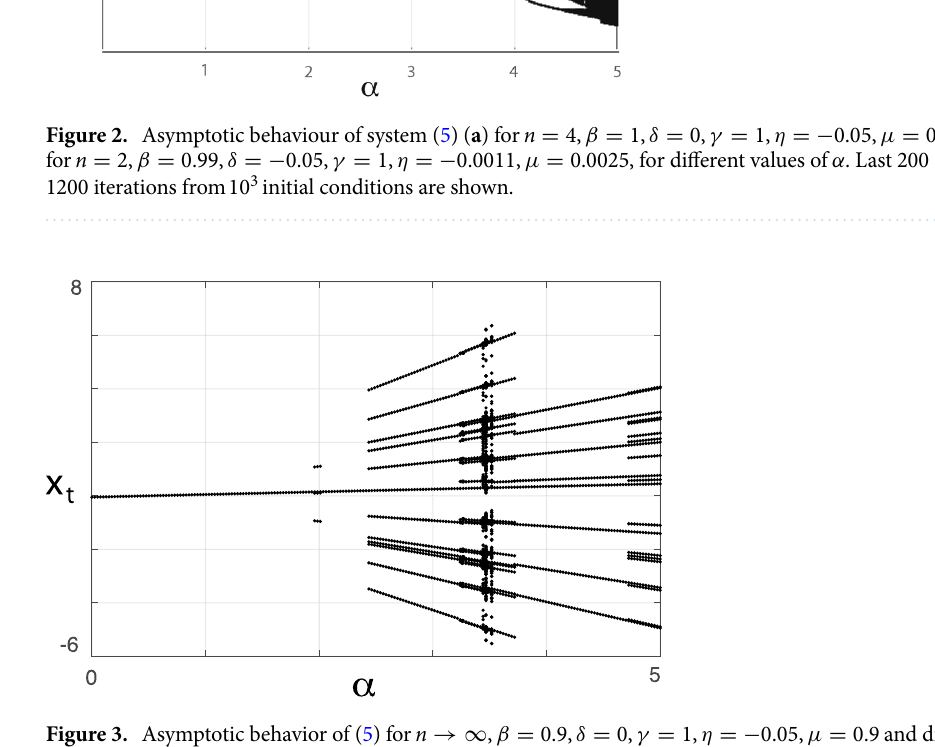
Figure 3. Asymptotic behavior of (5) for n values of α . Last 200 of 1200 iterations of 10 3 simulation